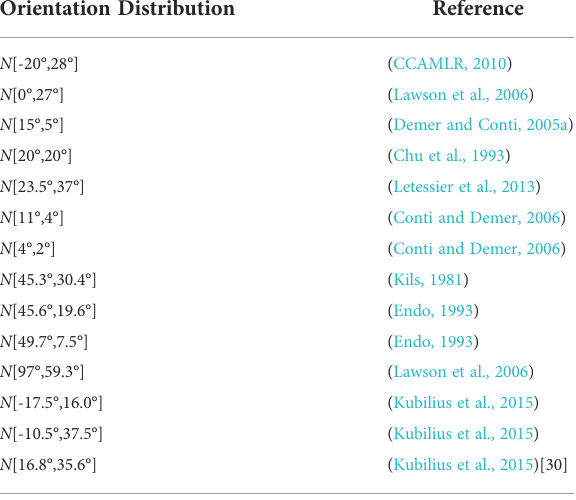
TABLE 1 Gaussian distributions of krill orientation angle reported in the